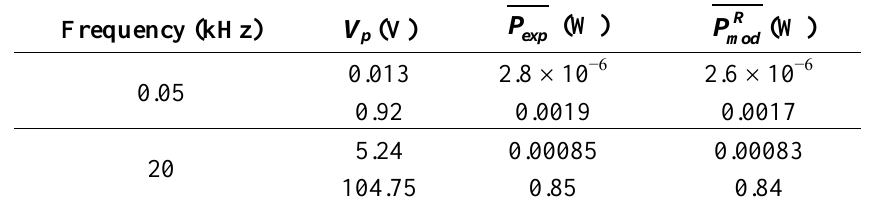
Table 1. Experimental and modeled average powers for two different values of the amplitude of the voltage waveforms ( V p